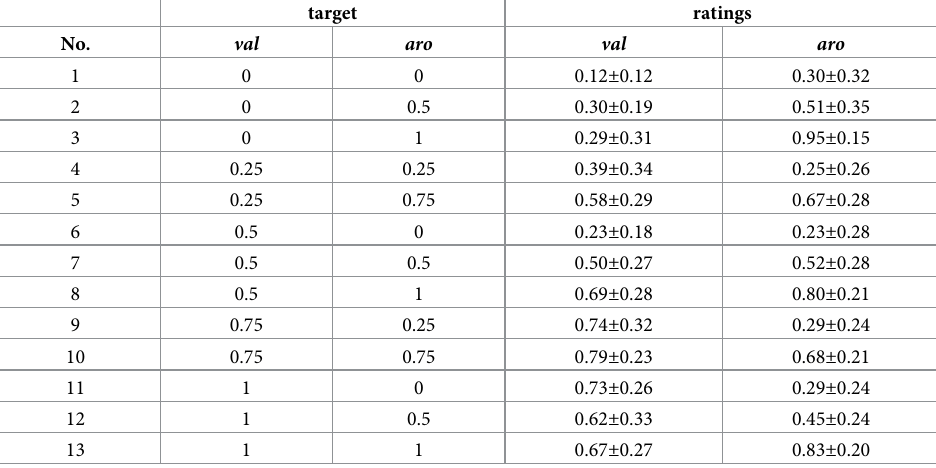
Table 1. Listening study results. The music generation system’s parameter settings (target valence/arousal) and corre- sponding perceptual ratings for valence and arousal (MEAN ± SD, n =